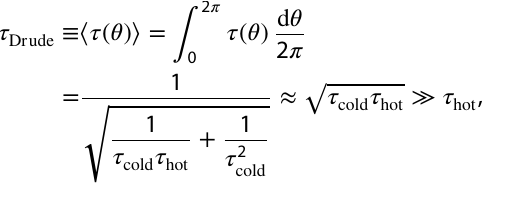
D 2 = S 2 . Heights around the 𝐩 𝐩 𝐩 𝐩